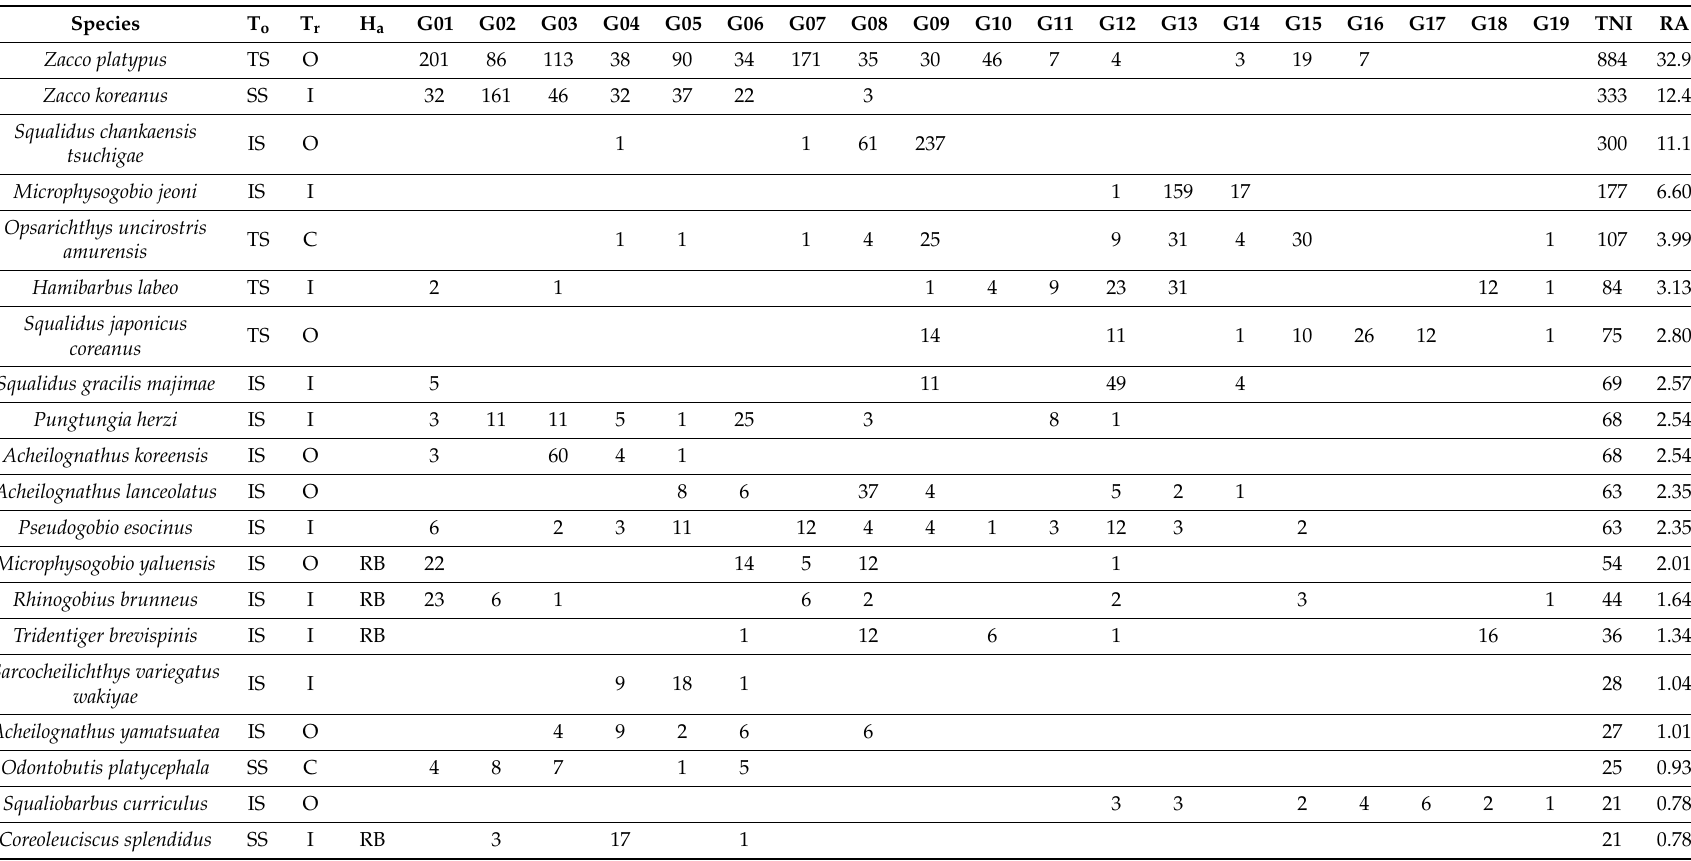
Table 2. Species composition analysis (To—tolerance guild, Tr—trophic guilds, Ha—habitat guilds, TS—tolerant species, SS—sensitive species, IS—intermediate species, O—omnivores, I—insectivores, C—carnivores, RB—ri ffl e benthic, TNI—total number of individuals, TNS—total number of species, RA—relative abundance, ¥—exotic